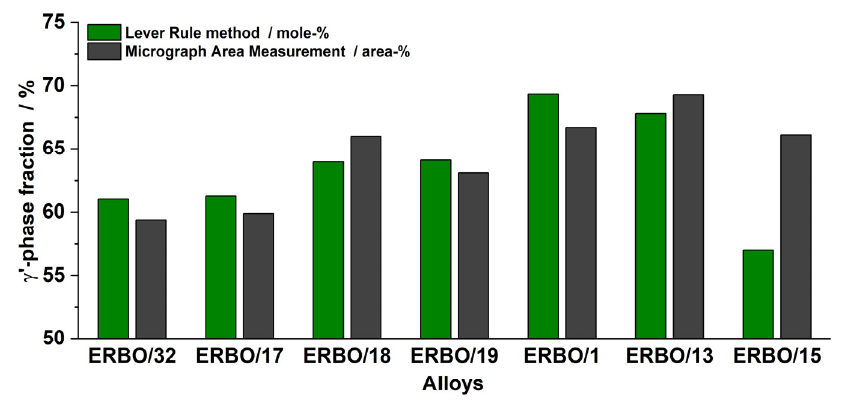
Figure 7. γ′ -phase fraction for single-crystalline ERBO/# alloys determined by the lever rule (left column) and micrograph area measurement method (right column).